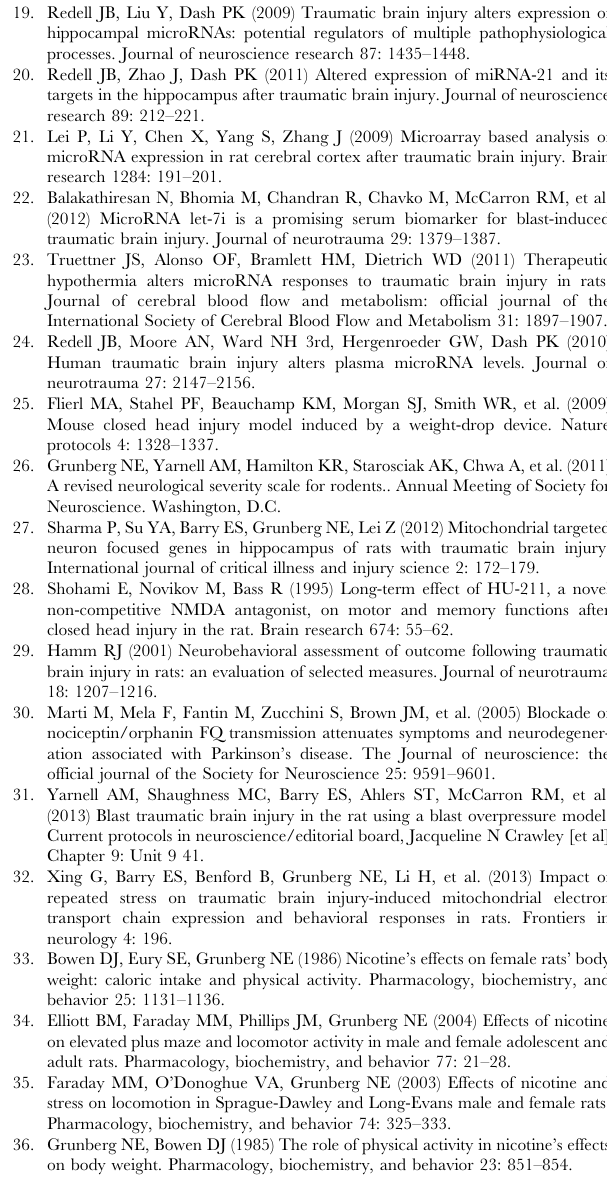
Table S13 Selection of the endogenous control miRNA. The most stable miRNA were selected based on their Ct values across the samples (n= 30). Ct for each miRNA from all the samples, irrespective of the injury or control group, were taken and Ct values with a SD , 1 were selected. Mean Ct were calculated to determine the abundance of miRNAs in the serum samples. To ensure that there are no outliers, median Ct was also calculated. MiRNA that showed similar mean and median Ct values were then selected. MiRNA that show more abundance i.e. , Ct , 25 were considered for determining a candidate stable endogenous miRNA in validation